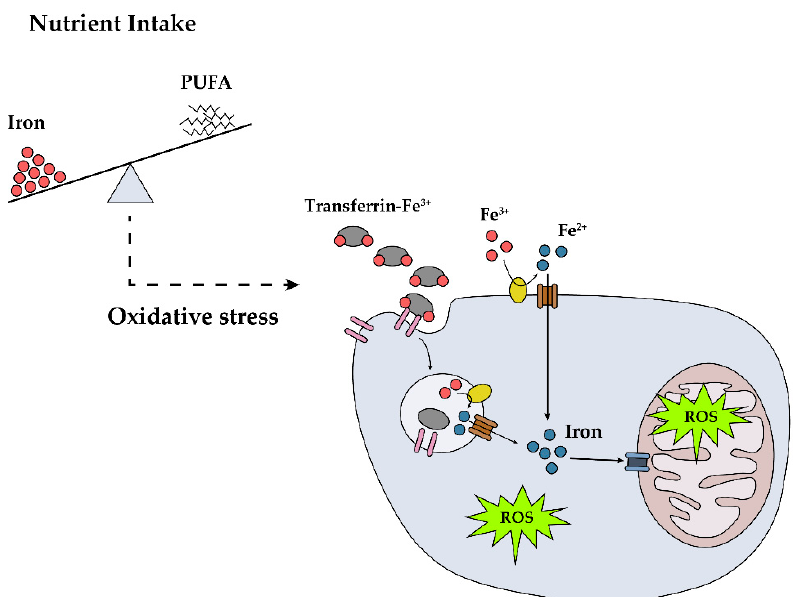
Figure 1. Potential role of dietary iron in the development of diabetic peripheral neuropathy (DPN). High dietary iron and iron intake relative to polyunsaturated fatty acids (PUFA) lead to DPN through reactive oxygen species (ROS) formation.